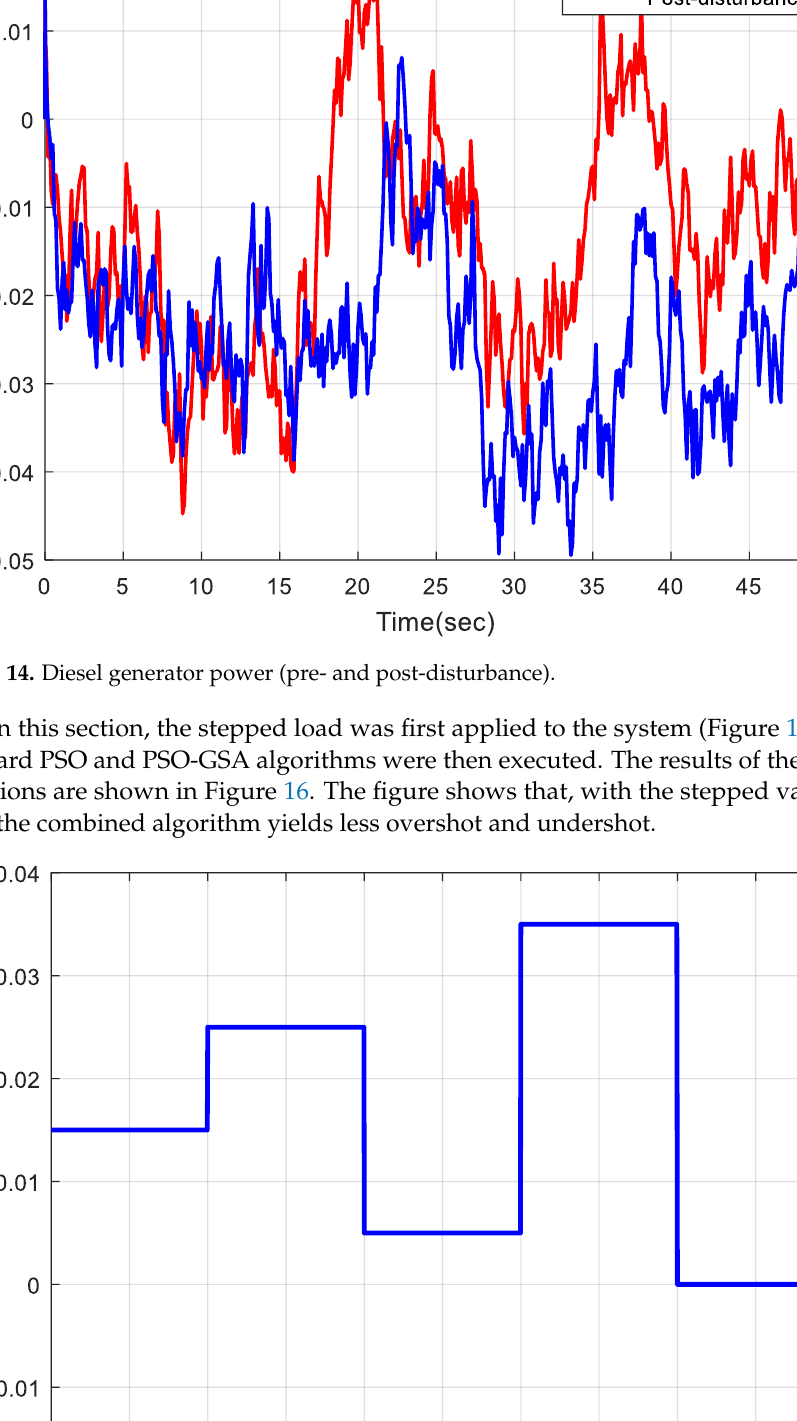
Figure 13. Flywheel power (pre- and post-disturbance).